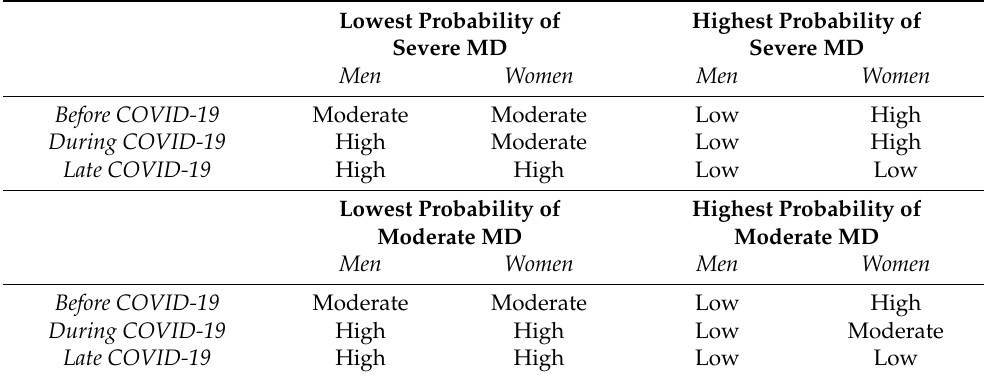
Table 4. Predictive probabilities of moderate and severe mental distress levels by physical exercise frequency and COVID19- era in men and